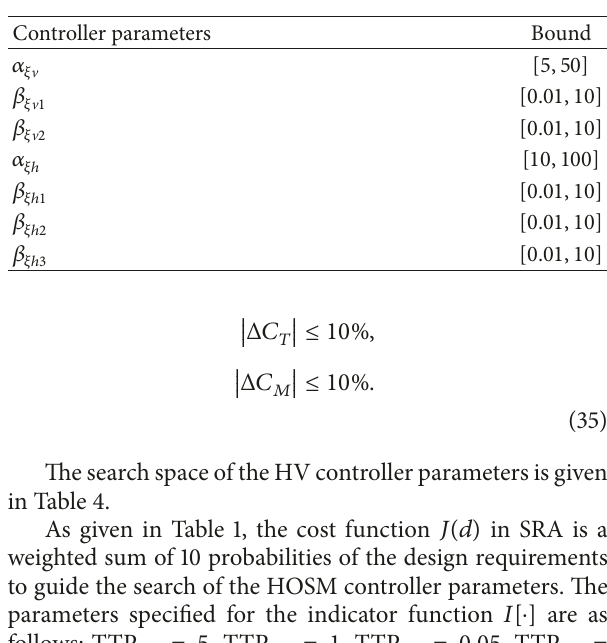
Table 4: Search space of HV controller